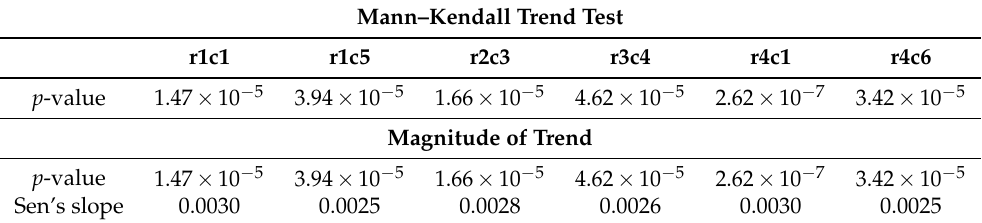
Table 2. Trend testing for selected grid points (temperature).